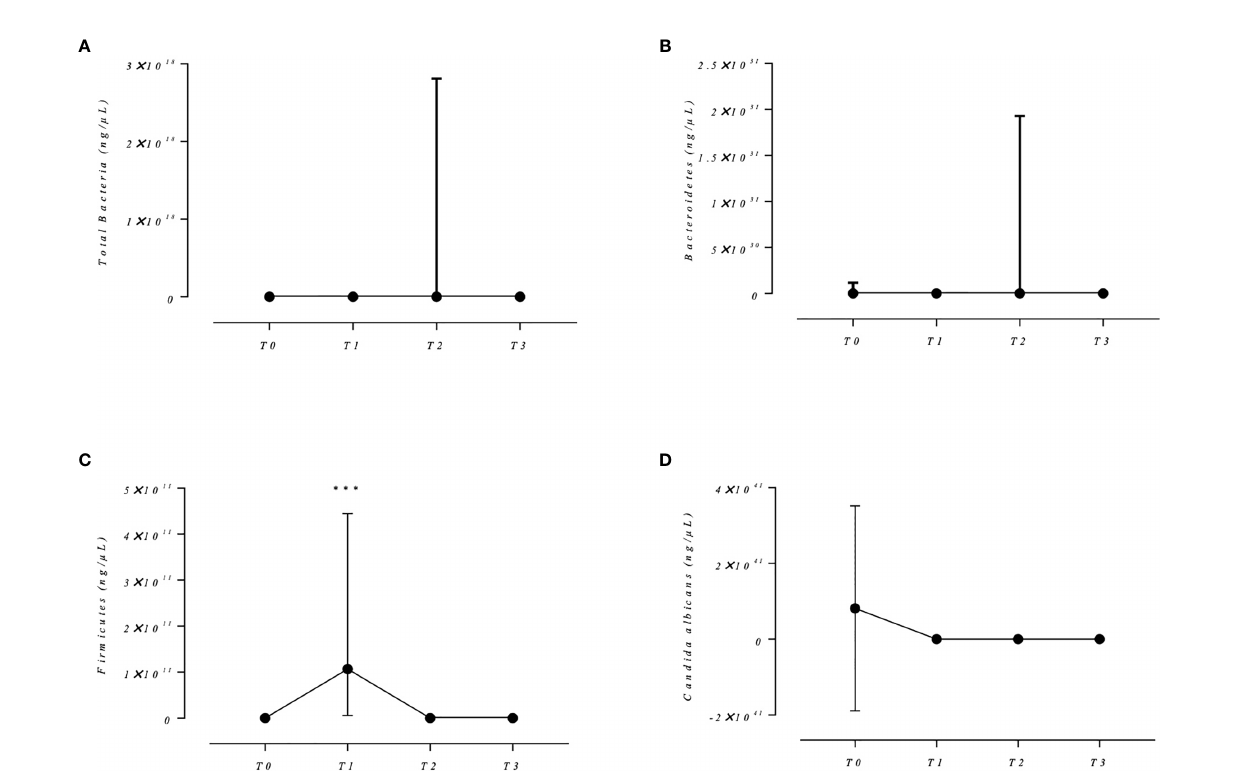
FIGURE 1 | Absolute quanti fi cation of total bacteria, Bacteroidetes and Firmicutes Phyla, and C. albicans from oral cavity of healthy patients submitted to impacted third molar surgery, after antiseptic and antibiotic intervention. T0: before surgery; T1: after 0.12% chlorhexidine mouthwash, for 3 days; T2: after amoxicillin 875 mg, single dose, 1 h before surgery, followed by amoxicillin 875 mg every 12 h, for 7 days after surgery; T3: 28 days after amoxicillin use. Statistical analyses were performed with a sample of 11 volunteers. h p²: Partial eta squared. Total bacteria, Bacteroidetes, and Firmicutes data were transformed by log 10 to achieve the RMANOVA premises. Candida albicans data were reciprocally transformed considering 1/ x . (A) Median and interquartile range of total bacteria levels (ng/μl). RMANOVA statistics for total bacteria: p -value = 0.387, power = 0.14, h p² = 0.100. Signi fi cant p -value for Mauchly ’ s test of sphericity required the Greenhouse- Geisser correction. (B) Median and interquartile range of Bacteroidetes levels (ng/μl). RMANOVA statistics for Bacteroidetes: p -value = 0.396, power = 0.16, h p² = 0.119. Signi fi cant p -value for Mauchly ’ s test of sphericity required the Greenhouse-Geisser correction. (C) Median and interquartile range of Firmicutes levels (ng/μl). RMANOVA statistics for Firmicutes: p -value = 0.000, power = 1.00, h p² = 0.949. Mauchly ’ s sphericity was assumed. ***Means p -value lower than 0.0000 after Bonferroni adjustment for multiple comparisons. (D) Median and interquartile range of Candida albicans levels (ng/μl). RMANOVA statistics for Candida albicans : p -value = 0.101, power = 0.51, h p² = 0.203. Mauchly ’ s sphericity was